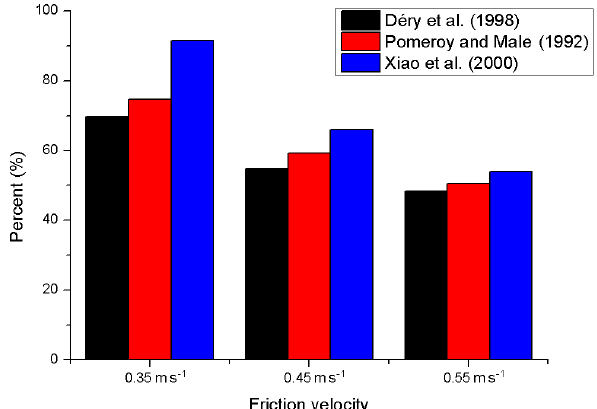
Figure 12. The ratio of sublimation mass below three heights to the total. Sublimation mass below a certain height is the sublimation mass that was ignored by other models (Déry et al., 1998; Pomeroy and Male, 1992, and Xiao et al.,